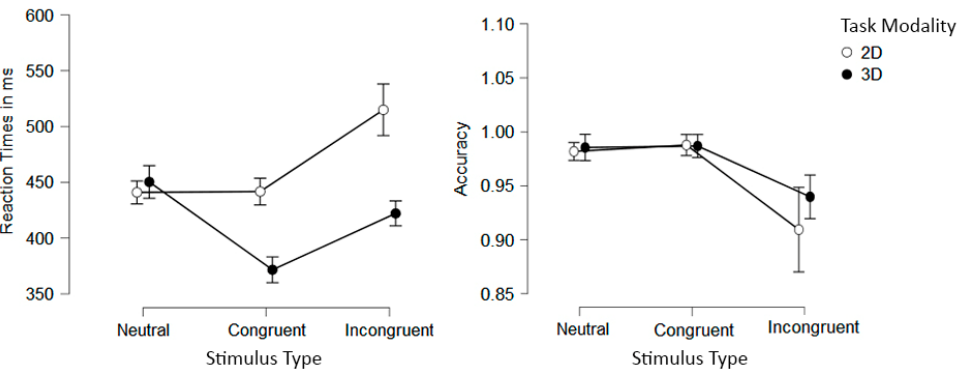
Figure 5. Mean RT (left) and accuracy (right) per Stimulus Type and Task Modality presentation Figure 5. Mean RT ( left ) and accuracy ( right ) per Stimulus Type and Task Modality presentation conditions. Error bars represent 95% confidence intervals. conditions. Error bars represent 95% confidence